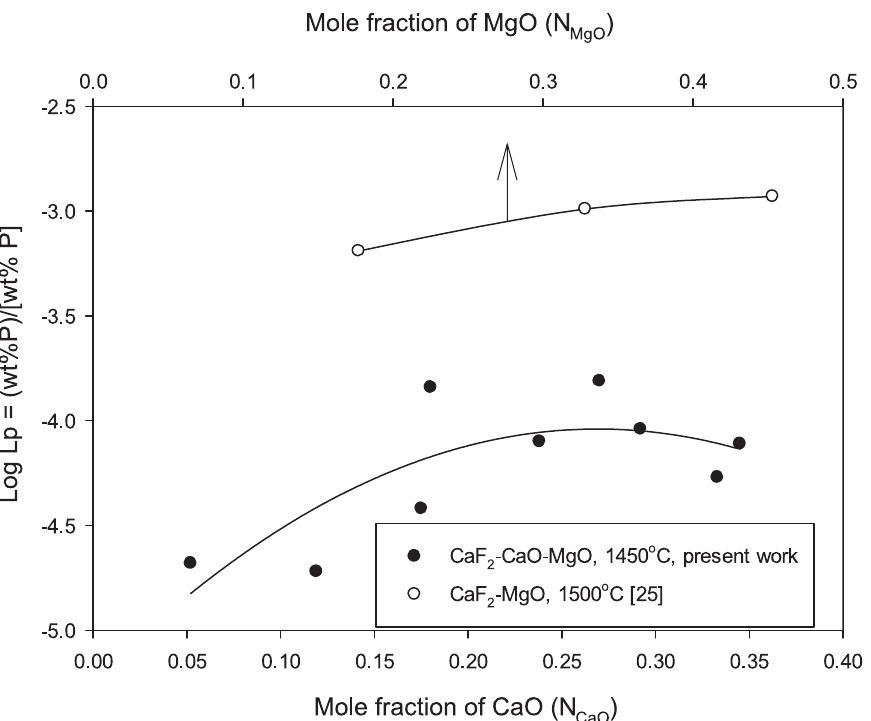
Fig. 5: Variation of phosphorus partition ratio (L P ) between molten Fe-carbon saturated-P alloy and MgO-CaF 2 and CaO-MgO-CaF 2 slags with mole fraction of basic